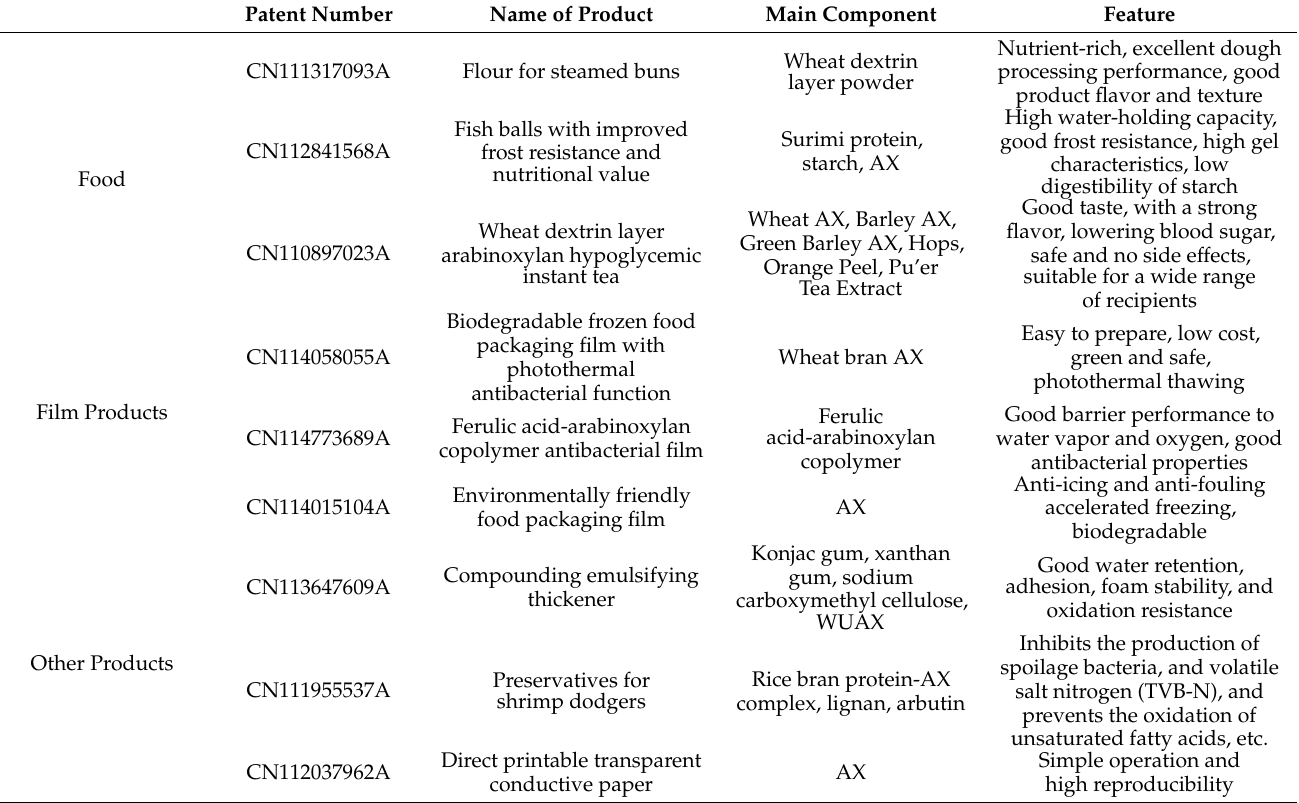
Table 4. AX product